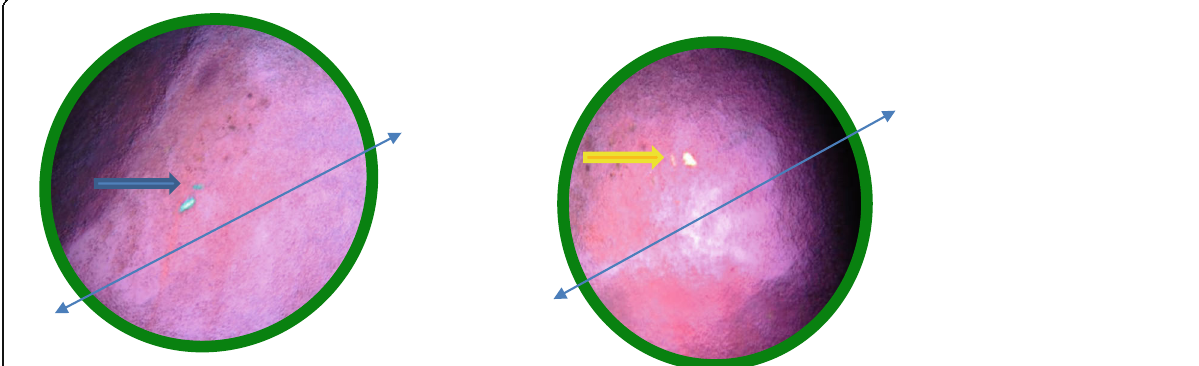
Fig. 4 CPPD crystals by polarized microscopy. Rhomboid-shaped positively birefringent crystal (blue when oriented parallel to the axis of the compensator (blue arrow) and yellow when perpendicular to the axis of the compensator (yellow arrow)) (magnification ×